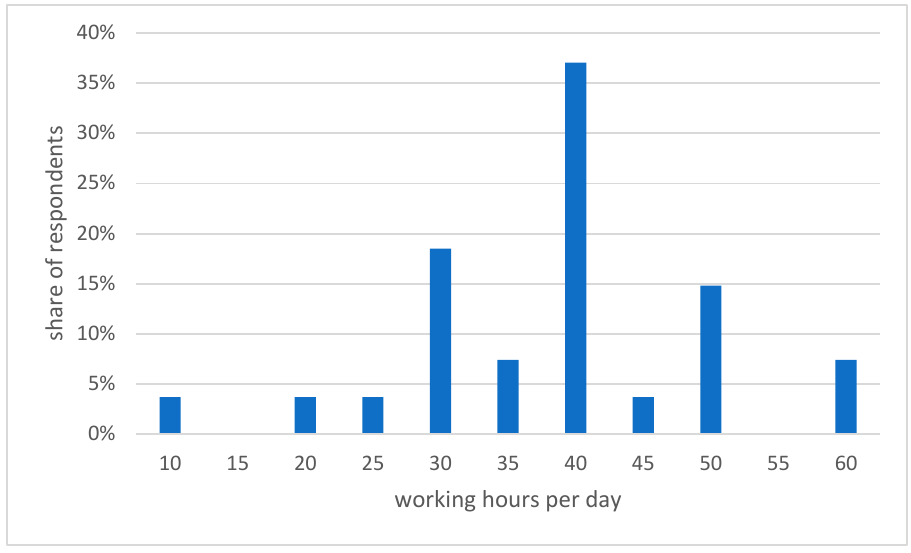
Figure 6. Regular weekly working hours of the tenants of the coworking space.